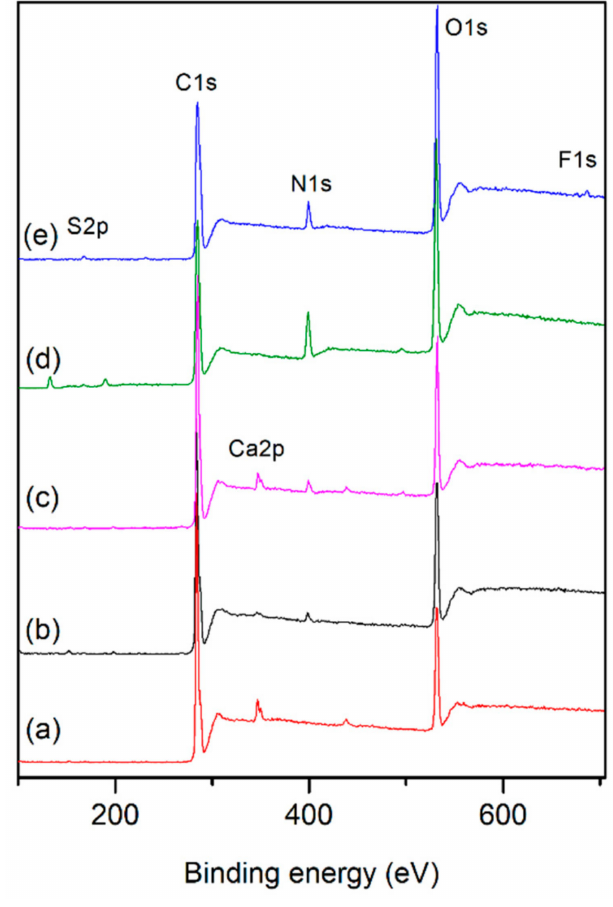
Figure 3. XPS spectra of ( a ) untreated PLA, ( b ) CS, ( c ) g -CS, ( d ) g -CS-ChS, ( e ) g -CS-ChS-L. In order to evaluate the changes in functional side groups before and after modifica- tions, the C1s and N1s spectra were deconvoluted with Avantage software as shown in Figure 4. The C1s spectrum of the untreated PLA surface contained three peak components and the peaks at 283.73 eV, 285.83 eV, and 287.79 eV are attributed to C-C/H, C-O, and O-C=OH/R bond, respectively. A significant increase in the C-O and COO species revealed that atmospheric plasma treatment in air resulted in an almost two-fold increase in oxygen- rich functional groups on the PLA surface. These increases in the molar concentration of C-O and COO species suggested the incorporation of hydroxyl, peroxyl, ether groups, or carbonyl groups on the polymer surface. These results are in agreement with the litera- ture [52,53]. Meanwhile, a new separated peak at 288.18 eV was observed after CS grafting onto polymer surface, which was attributed to -O-C-O- and -N-C=O groups of the intro- duced polysaccharide. Moreover, CS incorporation reduced the peak intensity of C=O bond as compared with plasma treated films, due to the coupling reaction of CS onto the PLA films. For ChS incorporated films ( g- CS-ChS), while the peak intensities of COO species significantly reduced, C-O, -O-C-O-, and -N-C=O group-related peak intensities